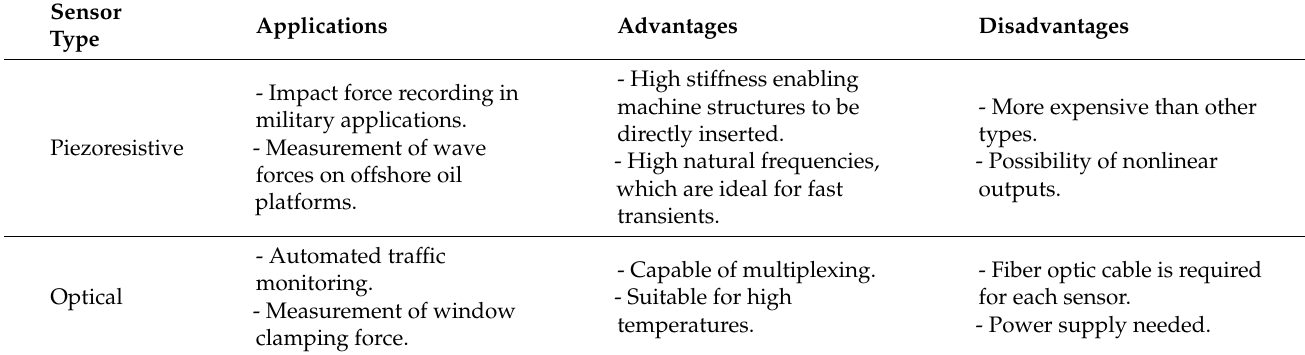
Table 22. Force sensors.